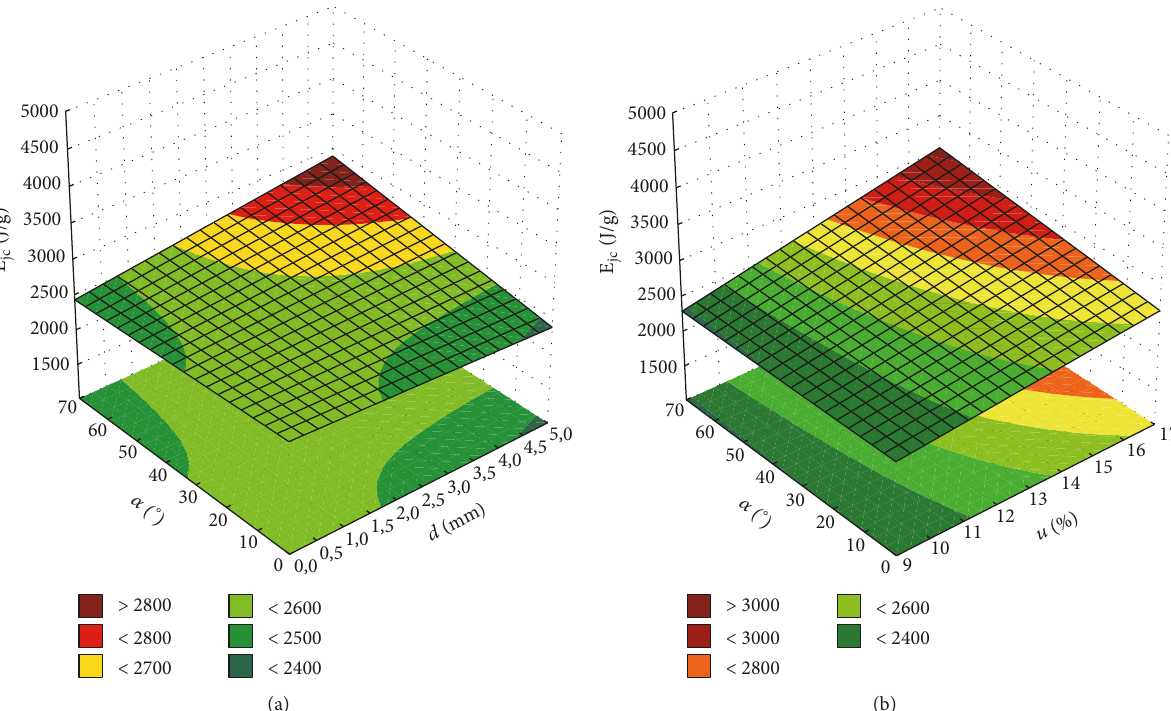
Figure 11: Response surface plots for the specific energy consumption of the extruder, E jc , versus the angle between the kneading elements, 𝛼 , and (a) width of the gap between the kneading elements, d, (b) mass fraction of talc,